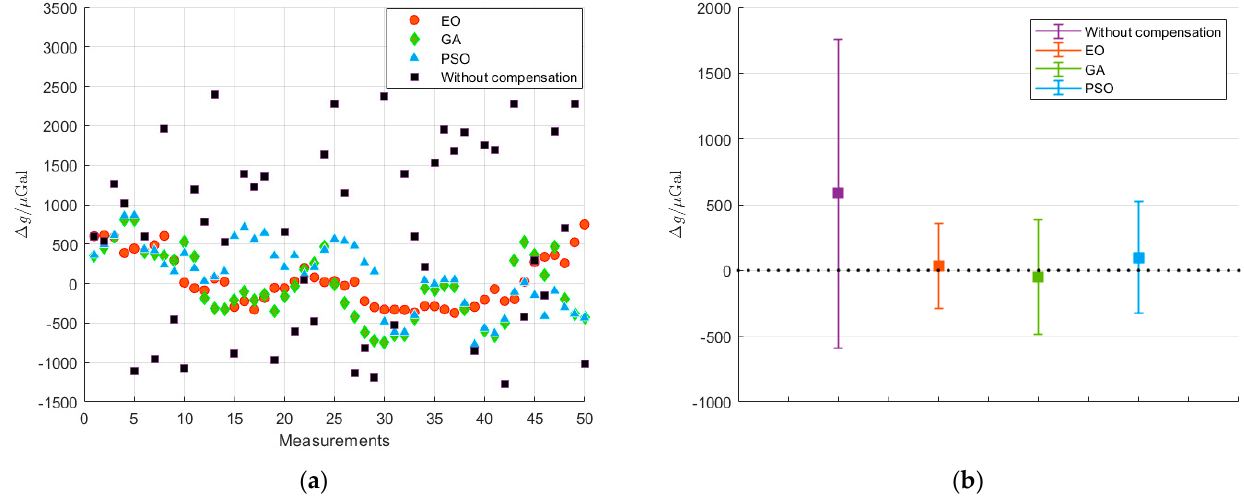
Figure 7. Measurement results after 50 vibration compensations. ( a ) ∆ g ; ( b ) mean value with error band.